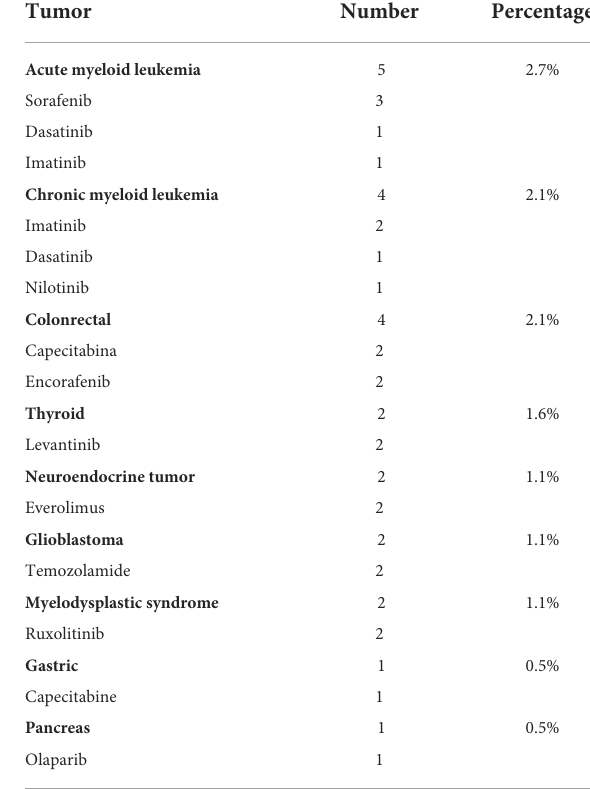
TABLE 1 Type of tumors and OAA of the patient included in the study.